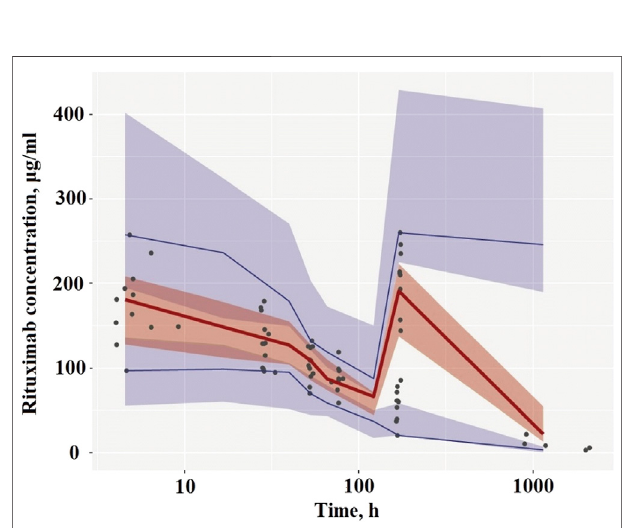
FIGURE 3 | Visual predictive check of the fi nal PK model. (A) Plots after the fi rst dose. (B) Plots after the last dose. Circles represent the observed concentrations. Solid lines represent the observed median, 5th and 95th percentiles of observed pro fi les. The shaded areas correspond to the simulation-based 95% con fi dence